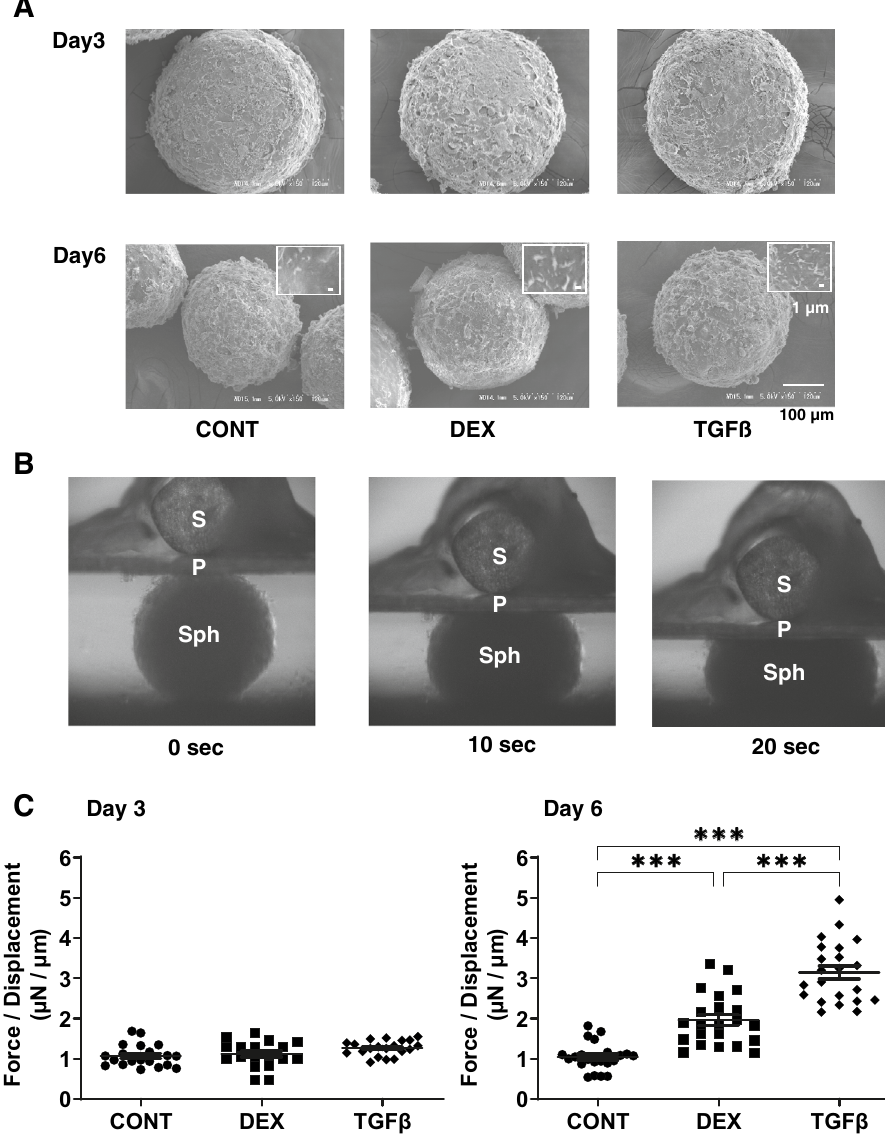
Figure 5. Ultrastructure and physical solidity of 3D HTM spheroids. Among the experimental groups treated with or without 250 nM DEX or 5 ng/ml TGFβ2, representative SEM images of 3D HTM spheroids at Day 3 or Day 6 are shown in Panel A (scale bar: 100 µm) and the physical solidity of their 3D spheroids at Day 3 and 6 was examined by a micro-squeezer. Numbers of ECM deposits of the 3D spheroid at Day 6 within 5 × 5 µm 2 (panel A inset; scale bar: 1 µm) were counted in 5 different areas from 4 different preparations (CONT; 4.75 ± 0.83, DEX; 7.25 ± 0.83, TGFβ; 10.25 ± 2.05). Regarding the micro-squeezer analysis among experimental groups, the force (μN) required to induce a 50% deformity of every single out of 15–20 freshly prepared 3D spheroids were measured over a period of 20 s (Panel B ; Sph: 3D spheroid, S: pressure sensor, P: compression plate) and force/displacement (μN/μm) values were plotted in Panel ( C ). Data are presented as the arithmetic mean ± standard error of the mean (SEM). *** P < 0.005 (ANOVA followed by a Tukey’s multiple comparison